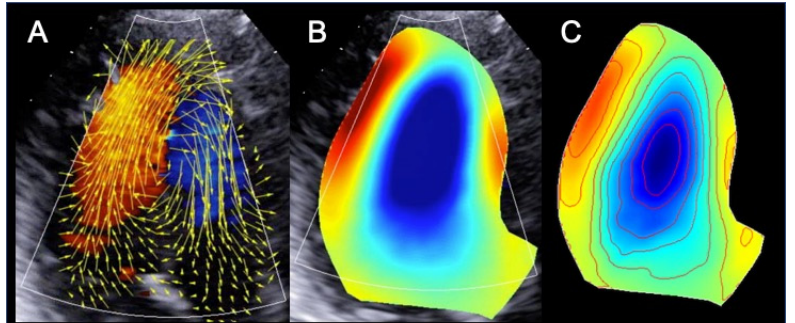
Figure 2. Intracardiac flow dynamics in a patient with dilated cardiomyopathy. Different maps were used to represent flow properties. The vector flow map ( A ) shows that the flow circulates along the posterolateral wall and is rotating anteriorly at the level of the left ventricular apex. In the circulation map ( B ) this translates into the formation of a single large vortex, that rotates clockwise (blue color) at the mid-apical portion of the left ventricle. The steady-streaming flow map of one heartbeat ( C ) shows the streamlines and the color map of the vorticity field. All images were obtained using the HyperDoppler software of an Esaote Mylab X8 echo-scanner without contrast injection.